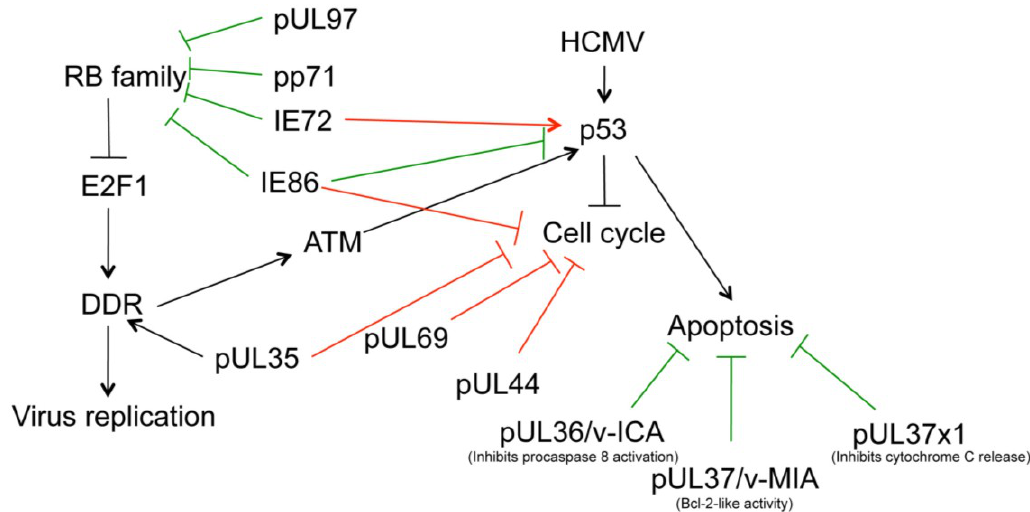
Figure 2. The relationship between cell cycle and the DDR induced by HCMV. Lines depicted in green represent activities that promote cell cycle progression or prevent the cells from undergoing apoptosis. Lines depicted in red represent activities that can negatively affect cell cycle progress within the